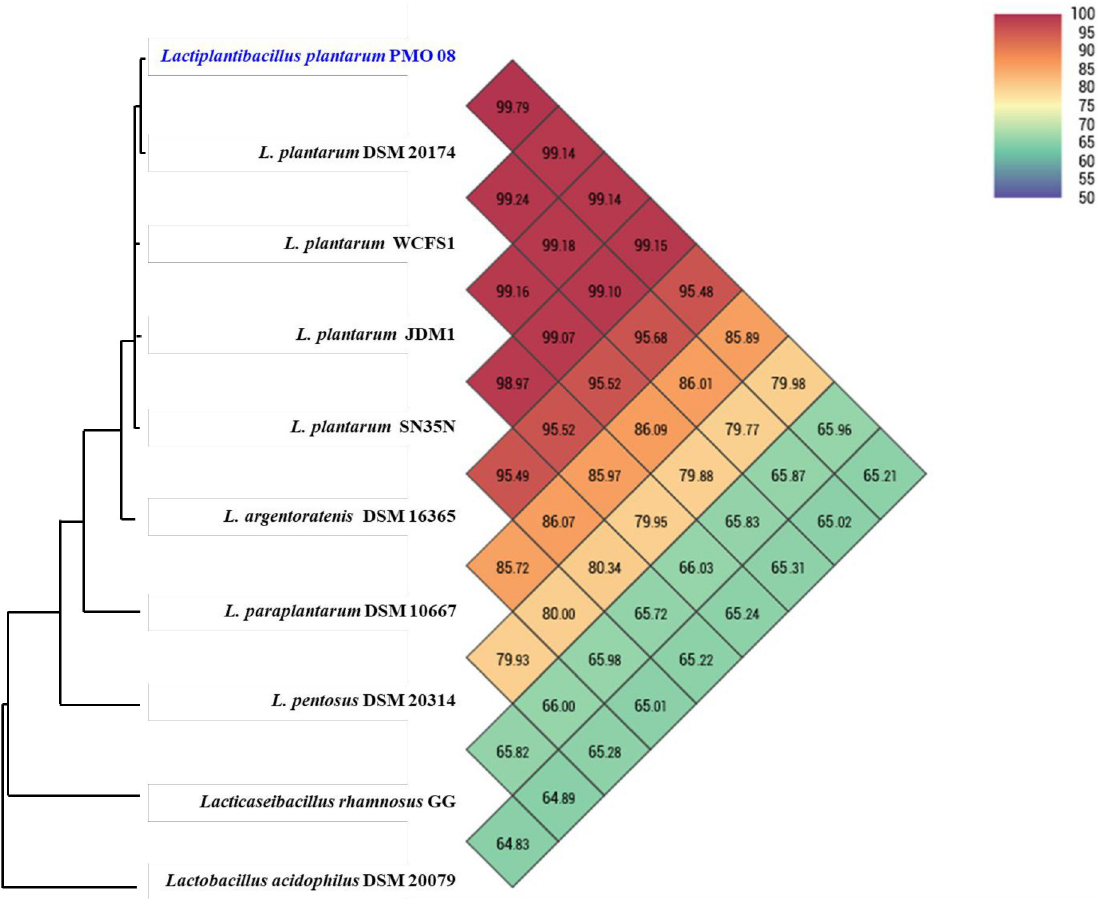
Fig 2. Heat map of OrthoANI of Lactiplantibacillus plantarum PMO 08 compared with other lactic acid bacteria. Each cell represents the OrthoANI values between the row and the corresponding genomes of the column. The phylogenetic tree on the left represents a